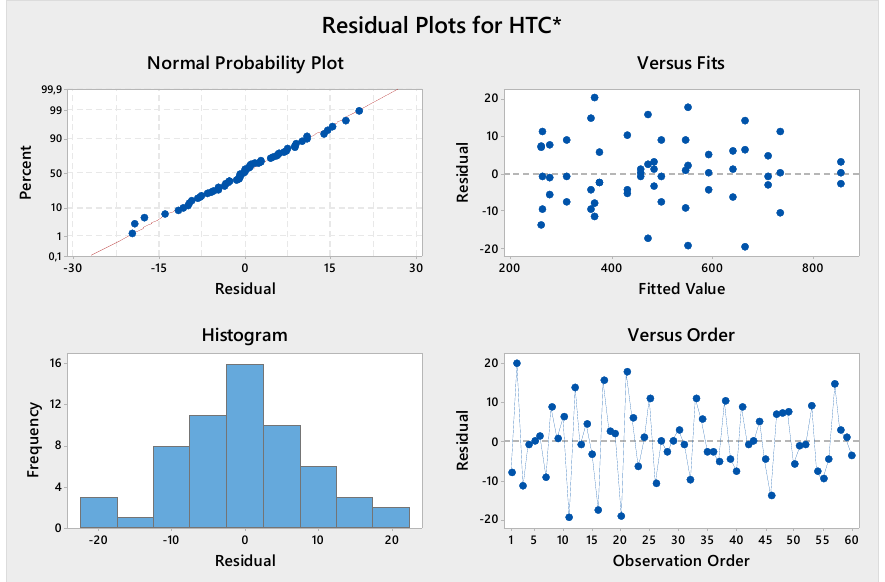
Figure 7. Residual plots for HTC* .